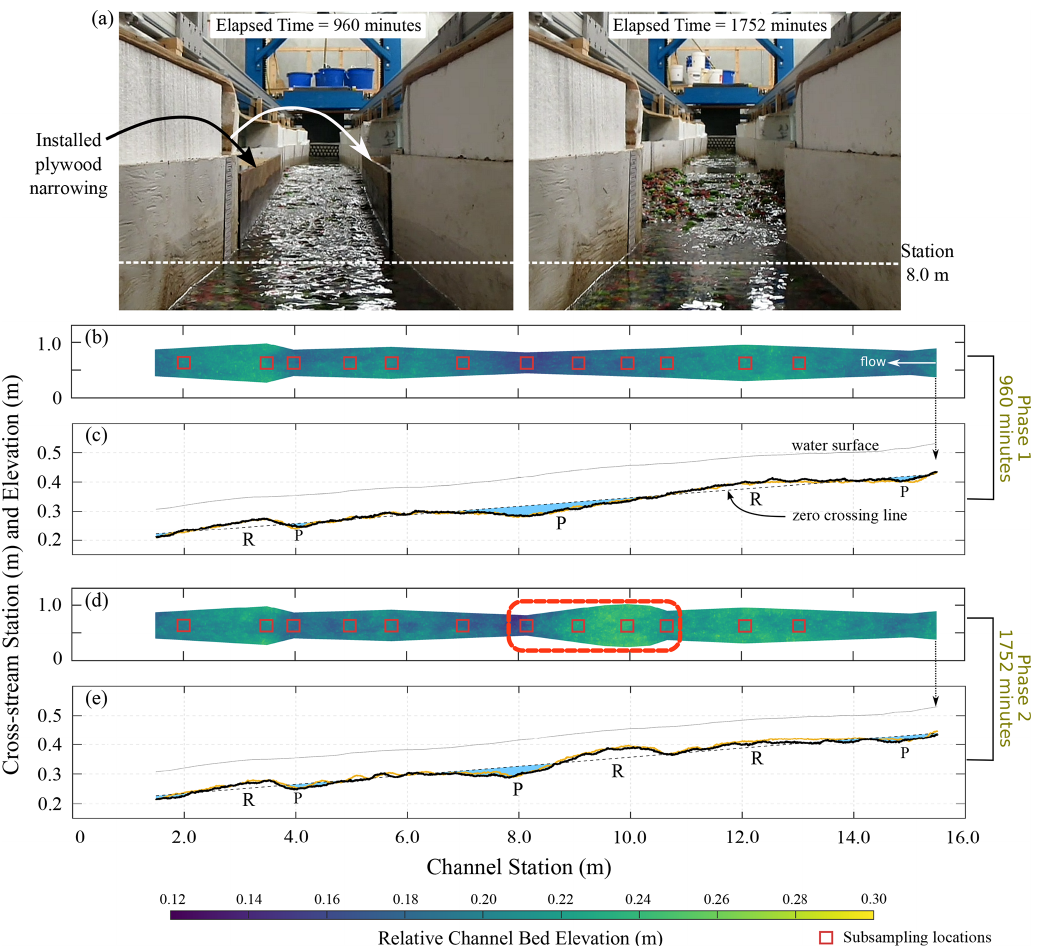
Figure 3. Experimental conditions at approximate topographic steady-state times during PRE4 for Phases 1 and 2. (a) Photographs at elapsed times of 960 and 1752min, taken just downstream of the narrowest channel segment. The location of the installed plywood to narrow the channel from station 10.6–8.15m is highlighted. There is a water supply of 5Ls − 1 for the image on the left and 2Ls − 1 for the image on the right. (b) Bed topography at elapsed time 960min. Red squares show locations where channel width and bed elevation were sampled to understand correlations between downstream width change and local bed slope. (c) Topographic profile at elapsed time 960min (thick black line), with the profile at 720min shown for discussion (thin orange line). (d) Bed topography at elapsed time 1752min. The bank positions were adjusted from station 10.6 to 8.15m, denoted by the dashed red polygon. (e) Topographic profile at elapsed time 1752min (thick black line), with the profile at 1680min shown for discussion (thin orange line). Water surface profiles were smoothed using a downstream windowed mean over a length scale of 0.5m. Topographic profiles were spatially averaged from digital elevation models for a centered cross-stream length scale of 0.160m. Zero crossing lines are calculated per Richards (1976). “P” stands for pool and “R” for riffle, with smaller font used for more subtle